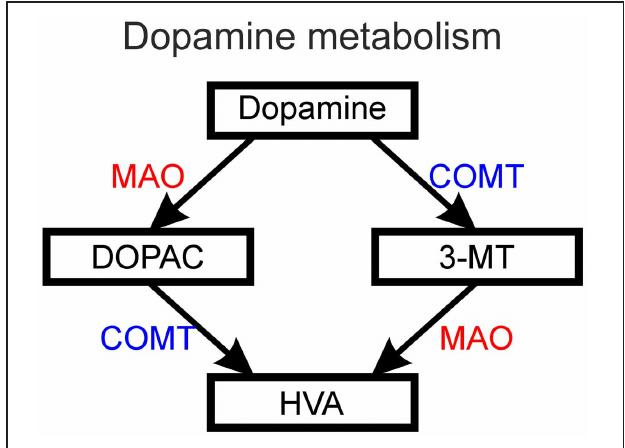
FIGURE 8 | The metabolism of dopamine into DOPAC (3,4-dihydroxyphenylacetic acid) and 3-MT (3-methoxytyramine) followed by metabolism of these intermediate products into HVA (homovanillic acid) by the action of MAO (monoamine oxidase) and COMT